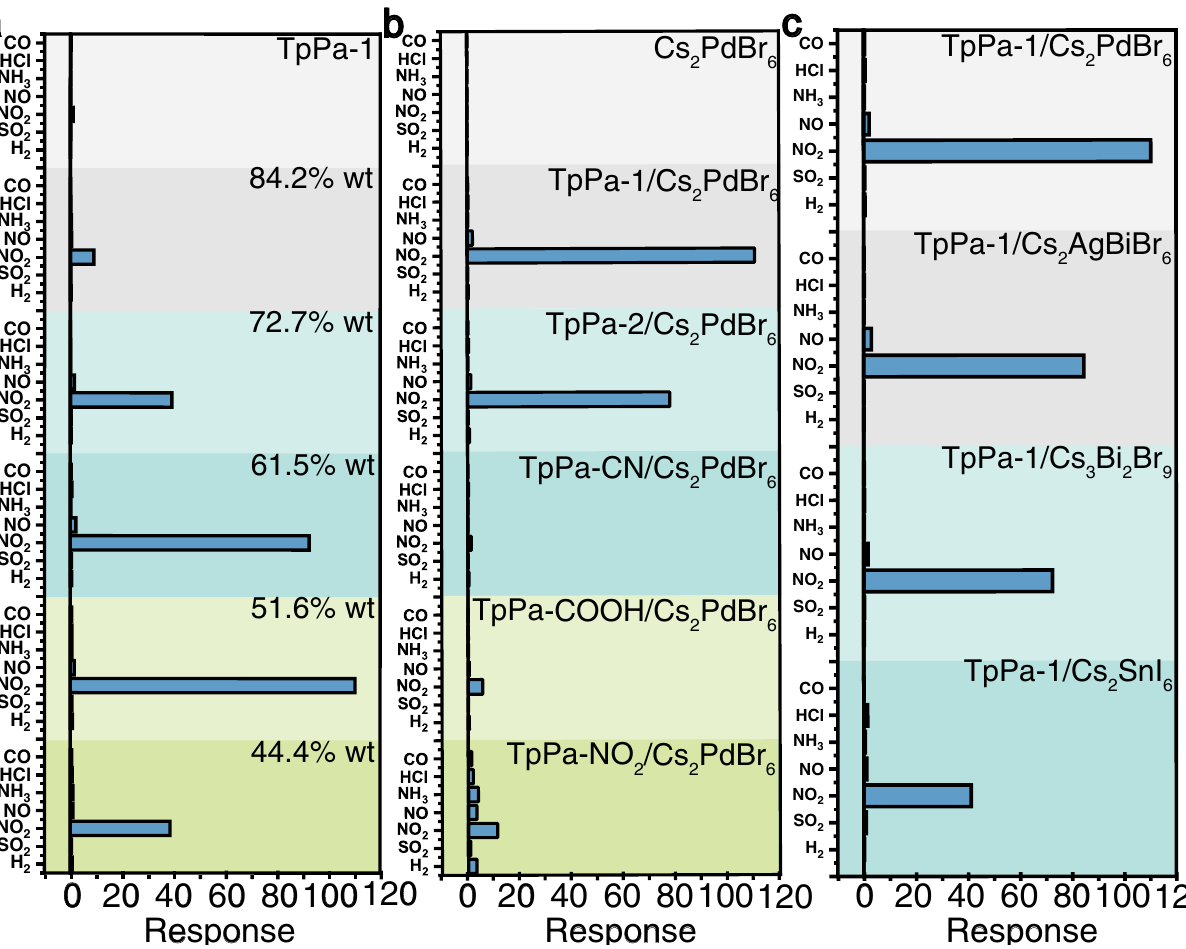
Fig.3|Comparisonofsensorgasresponseandselectivityperformance(allgas concentrations are 2ppm). a The response of TpPa-1 to different gases after mixing different proportions of Cs 2 PdBr 6 . b The response of different COFs to